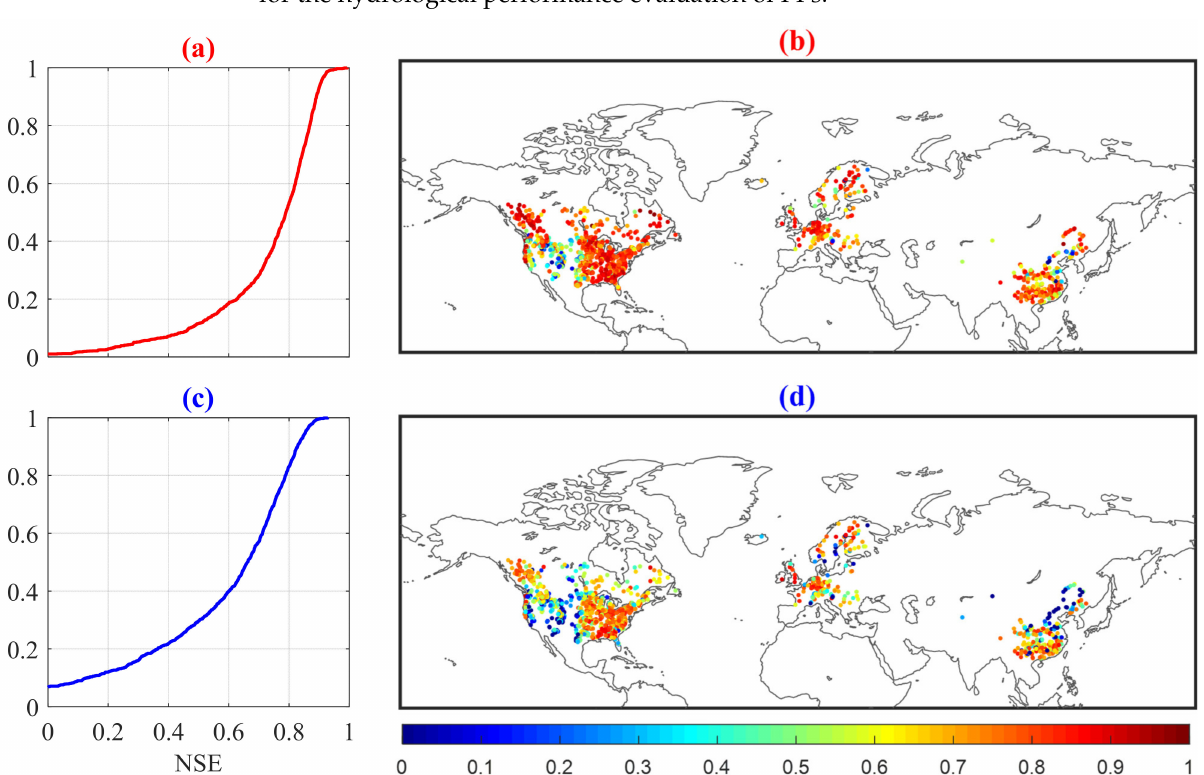
Figure 4. Spatial pattern and Cumulative Distribution Function (CDF) of NSE obtained by running XAJ with gauge-observed precipitation over 1382 catchments. ( a , b ) are for the calibration period, ( c , d ) are for the validation